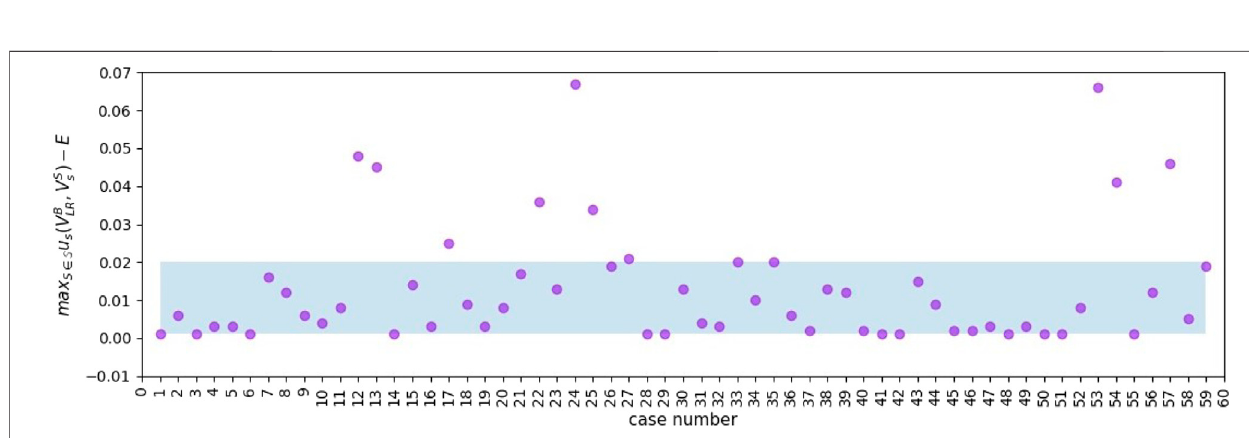
Frontiers in Physics |